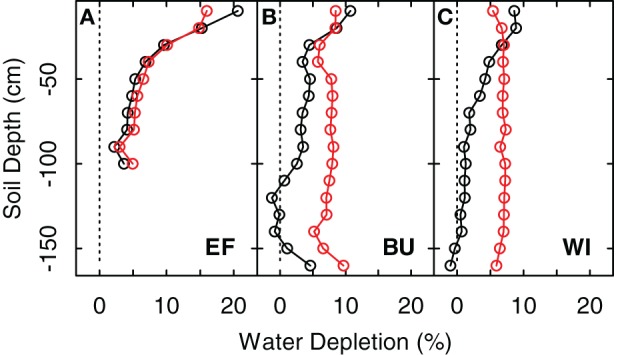
Extraction profiles and extraction values for three vineyard sites (EF, BU, WI; A–C) expressed as differences between maximum soil water content (FTSW = 100%) and soil water content on May 15th 2011 (before grapevine transpiration started) (black line and dots) and the difference between maximum soil water content and soil water content at the end of the growing season in 2011 (1-Nov-2011) (red line and dots).